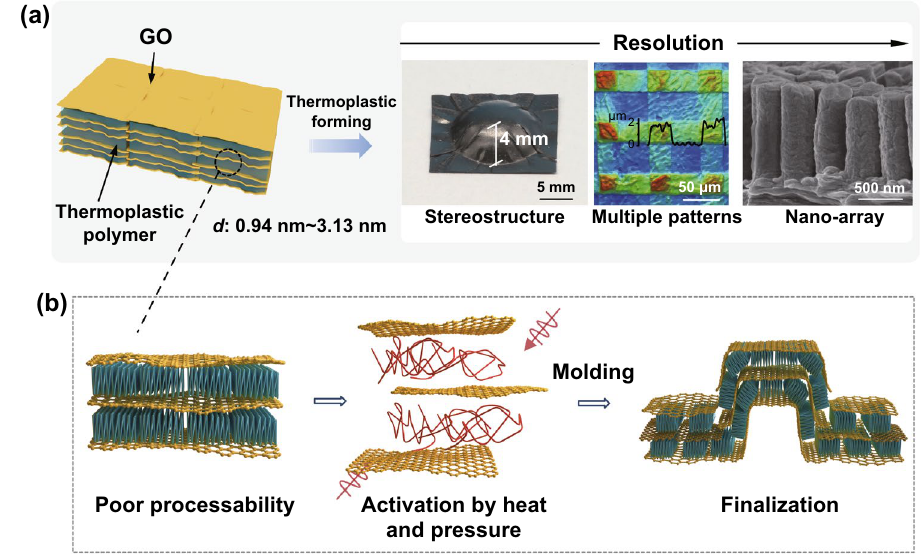
Fig. 1 a The thermoplastic forming process of Pi-GOS from flat films into different embossed structures ranging from macro- to nano-scale. b Schematic diagram of the thermoplastic mechanism, including the sliding of GO sheets and the activation of polymer chains under pressure and